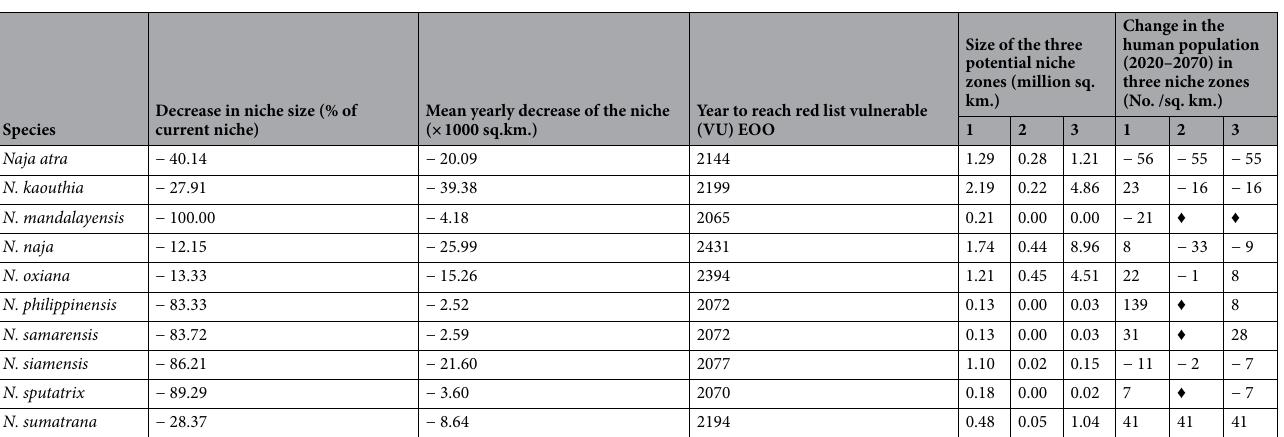
Mean yearly decrease of the niche (× 1000